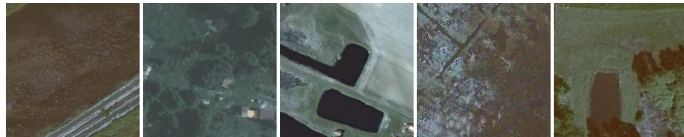
Figure 9. Partial display of LandCover Dataset.